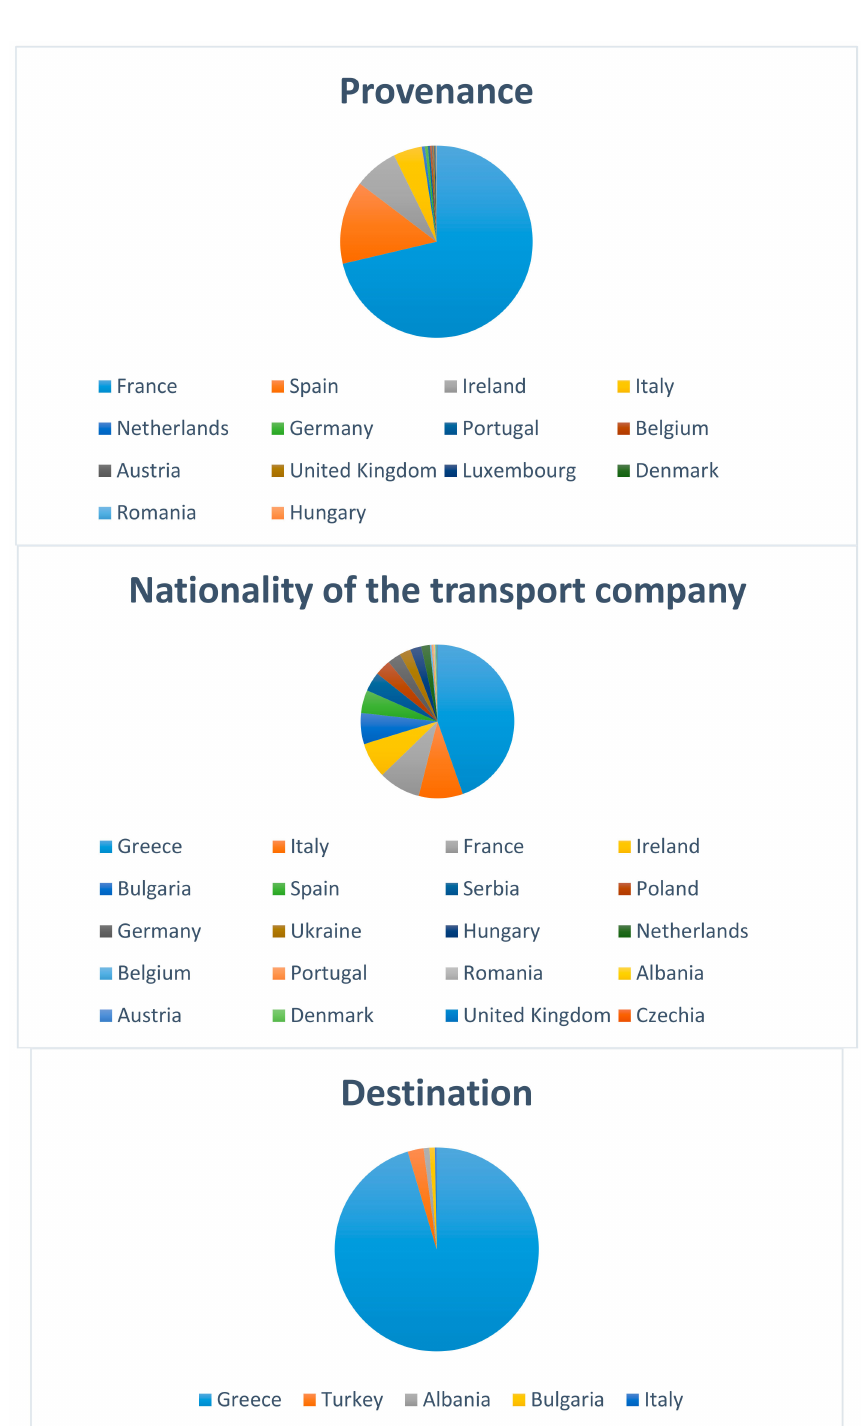
Figure 2. Pie chart by provenance, nationality of transport company, and destination for the 1391 trucks which stopped at control post CE 07/PS Bitritto (Bari, Italy) from 2010 to